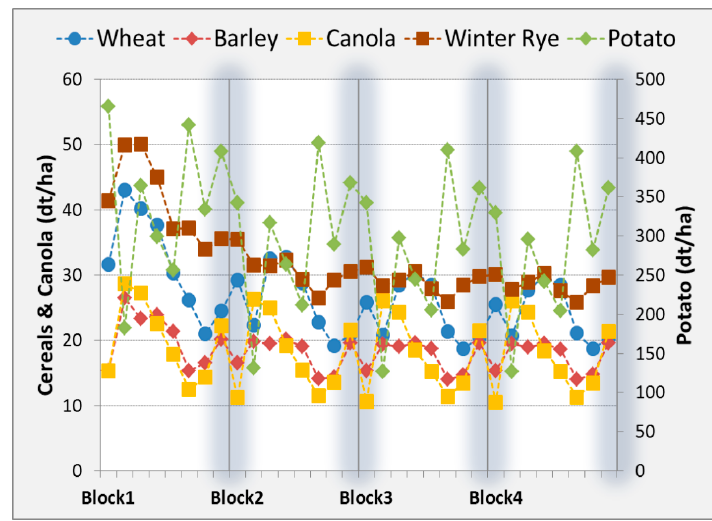
Figure 9. Yield dynamics in continuous rotation.